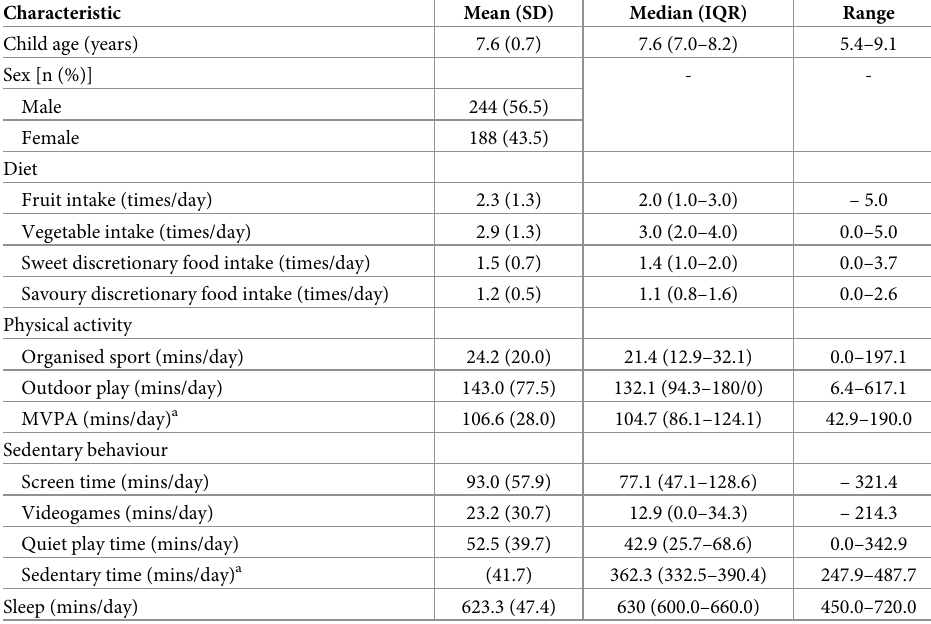
Table 2. Characteristics of the sample included in the analysis (n =